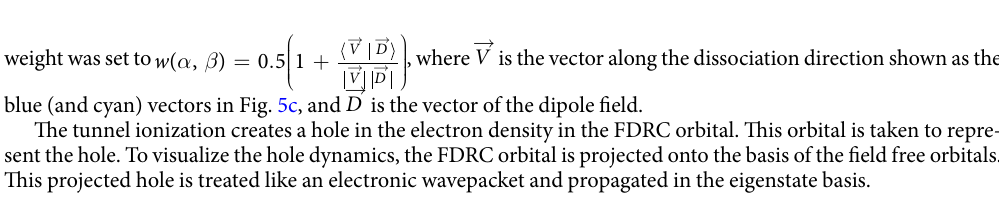
Figure 8. Relevant angles α , between the dipole field and the molecular orientation (in this case the C-C axis), and β , between the dipole field and the C-H dissociation